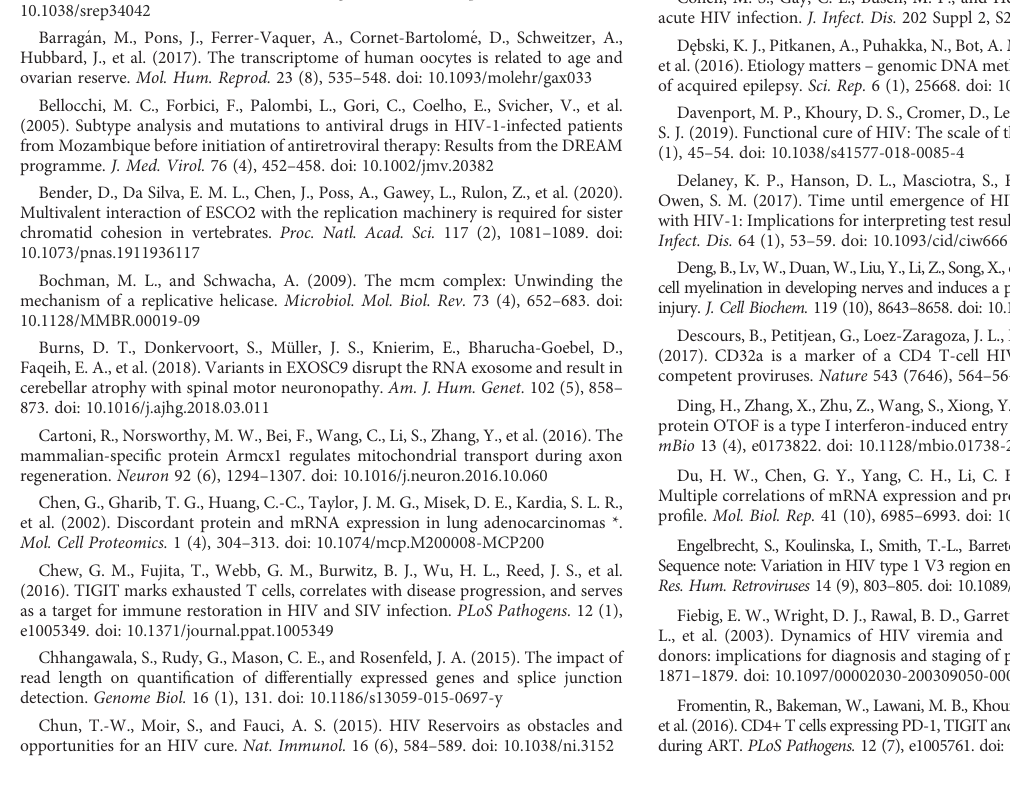
SUPPLEMENTARY TABLE 1 Full list of differentially expressed genes – acute HIV cases versus HIV negative controls. # = Rank by adj.P.Val; EnsemblID = Ensembl Stable ID name of the transcript; HGNC = HUGO Gene Nomenclature Committee name of the gene; logFC = Log 2 fold change; AveExpr = average expression across all samples, in log2 counts per million reads; adj.P.Val = Benjamini- Hochberg false discovery rate adjusted p-value. SUPPLEMENTARY TABLE 2 Full list of differentially expressed genes that correlate with viral load in acute HIV cases. # = Rank by rho; EnsemblID = Ensembl Stable ID name of the transcript; HGNC = HUGO Gene Nomenclature Committee name of the gene; rho = Spearmancorrelationcoef fi cient;adj.P.Val=falsediscoveryrateadjustedp-value.